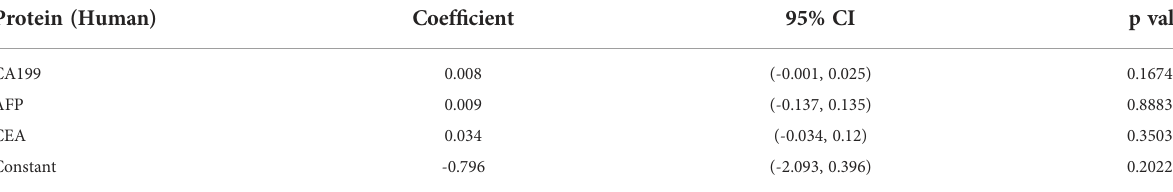
TABLE 4 The three-protein logistic regression classi fi er for diagnosis of advanced stage in GAC. Protein (Human)